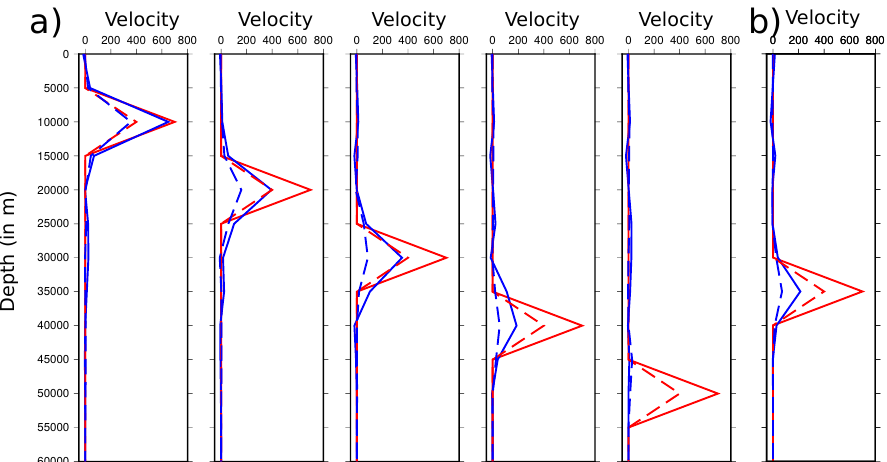
Figure A12. Results from spyke tests for two different case. We analyzed the resolution of ( a ) the R 2 structure (distance = 65 km on the profile in Figure 4) at different depths (10–20–30–40–50 km). ( b ) the lowest Vp/Vs ratio value of structure C 3 at distance = 130 km and 35 km depth. Red lines corresponds to the initial model while the blue lines are for the inversion results. Solid lines correspond correspond to P-wave velocity and dashed lines for S-wave velocity. See text for